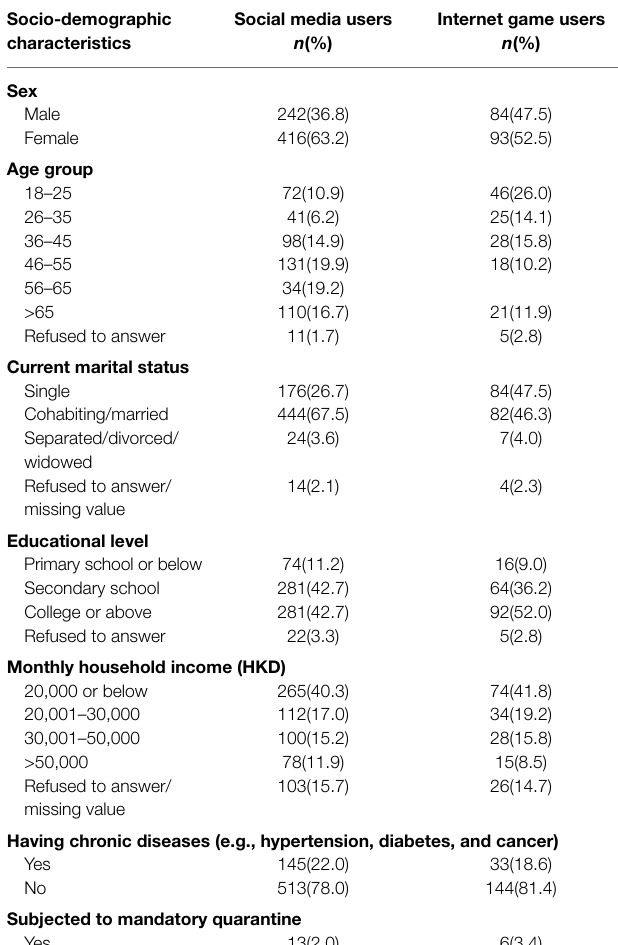
TABLE 1 | Socio-demographic characteristics of the